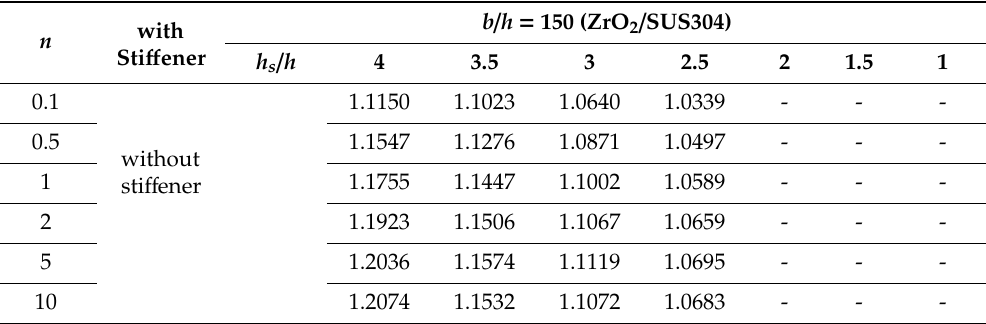
Table 14. The mass reduction between ZrO 2 / SUS304 plate with and without a central sti ff ener ( b / h = 150).